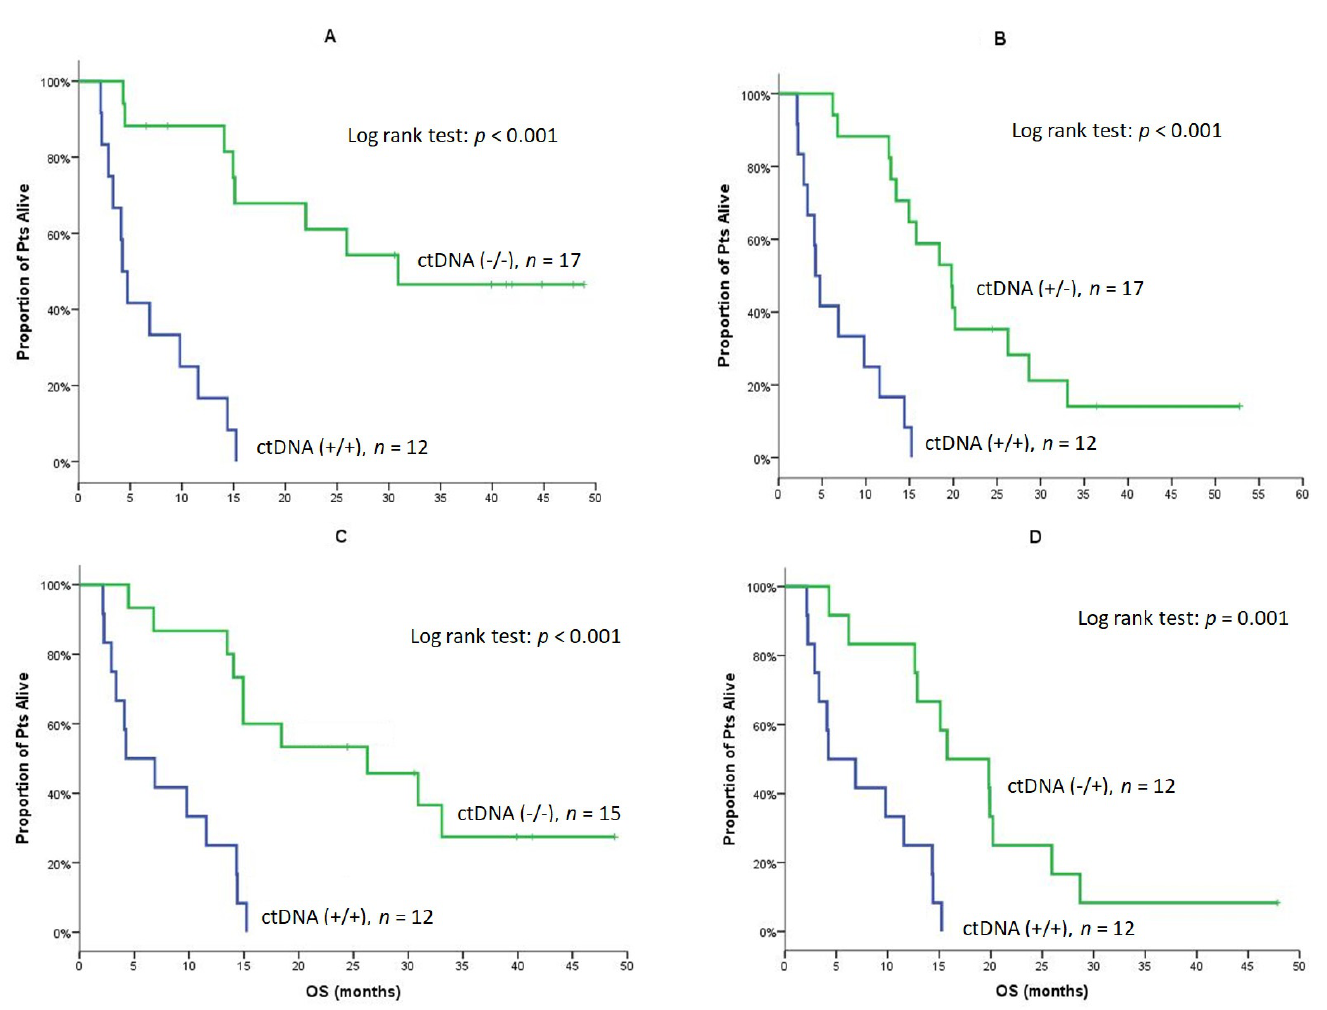
Figure 4. OS of patients according to changes of ctDNA at Baseline, Post-1 and at the EOT ( A ). Median OS of patients with detectable ctDNA at Baseline and Post-1 [Pre (+)/Post-1 (+)] compered to those without detectable ctDNA at both time points [Pre ( − )/Post-1 ( − )]. ( B ) Median OS of patients with detectable ctDNA at Baseline and Post-1 [Pre (+)/Post-1 (+)] compared to those with detectable ctDNA at baseline and non-detactable ctDNA Post-1 [Pre (+)/Post-1 ( − )]. ( C ) Median OS of patients with detectable ctDNA Post-1 and at the EOT [Post-1 (+)/EOT (+)] compared to patients without detectable ctDNA at both time points [Post-1 ( − )/EOT ( − )]. ( D ) Median OS of patients with detectable ctDNA Post-1 and at the EOT [Post-1 (+)/EOT (+)] compared to patients without detectable ctDNA at Post-1 and detectable ctDNA at the EOT [Post-1 (-) / EOT (+)]. Table 5. PFS and OS according to changes in ctDNA at Baseline, Post-1, and the EOT. PFS